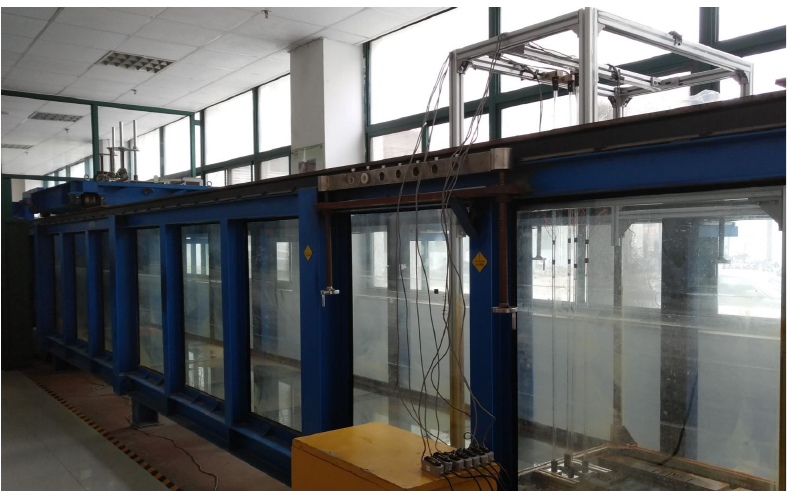
Figure 8. Water tunnel facility located in the Ocean Engineering Laboratory of China University of Petroleum (East China).